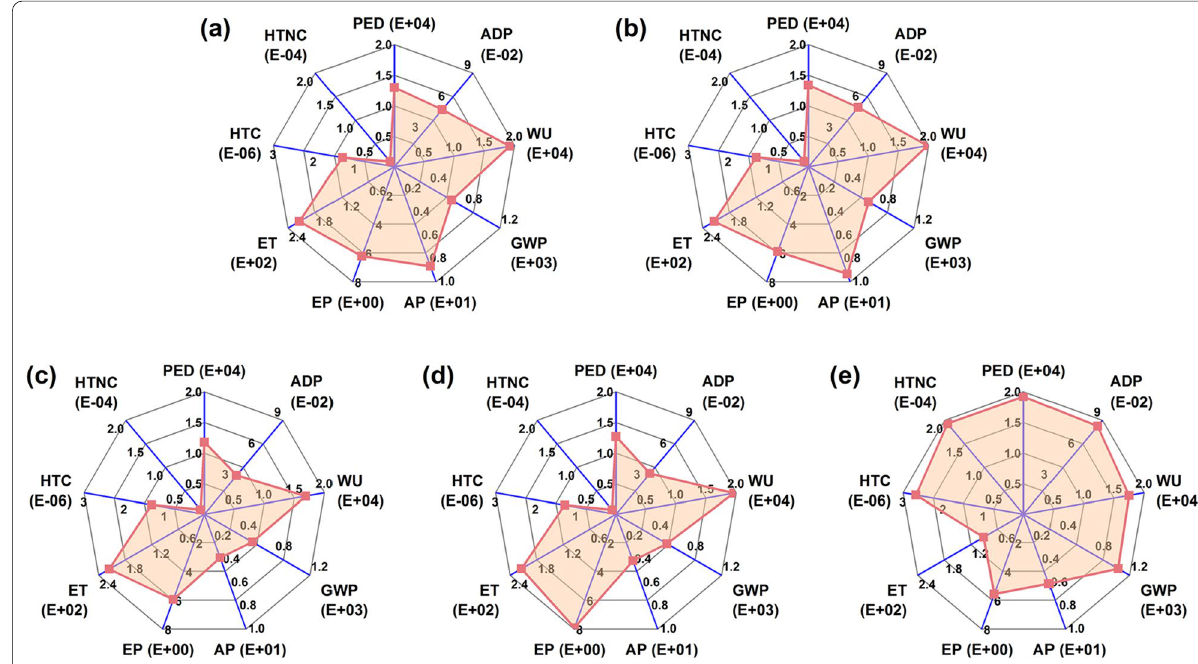
Fig. 6 LCIA results of SR ( a ), SNR ( b ), OSR ( c ), PR ( d ), and CP ( e ) use processes (obtained from the characteristic values shown in Additional file 1: Tables